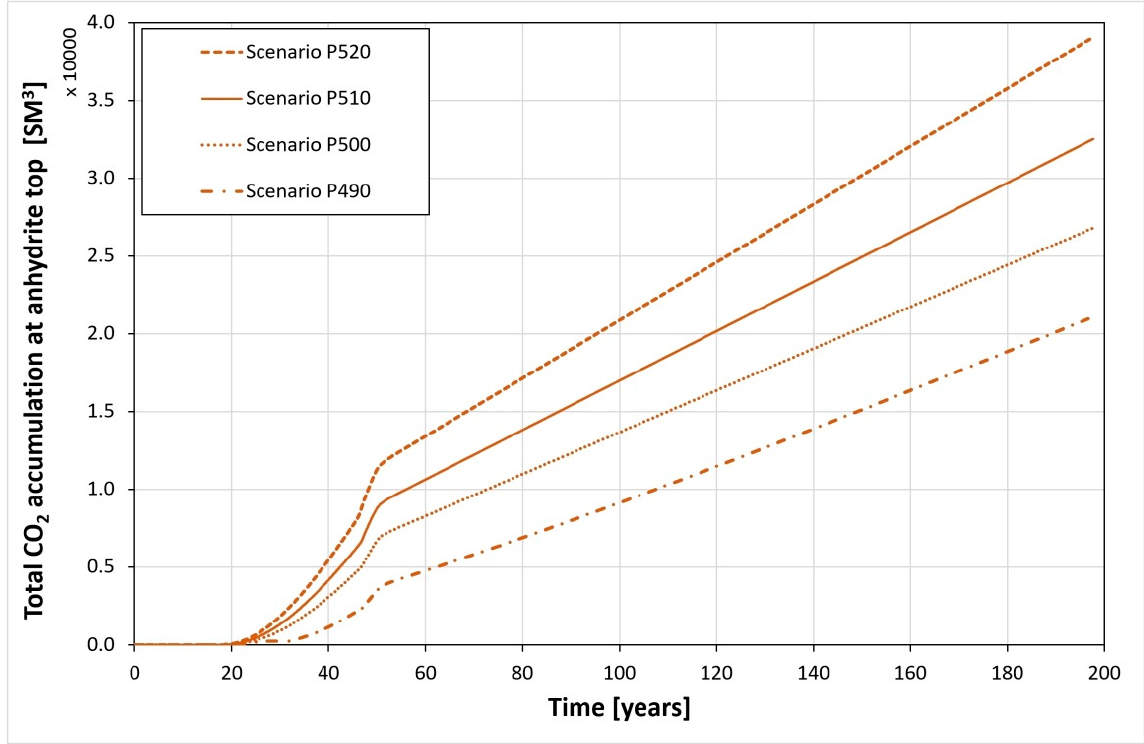
Figure 27. Total CO 2 accumulation at the anhydrite top for various injection scenarios.